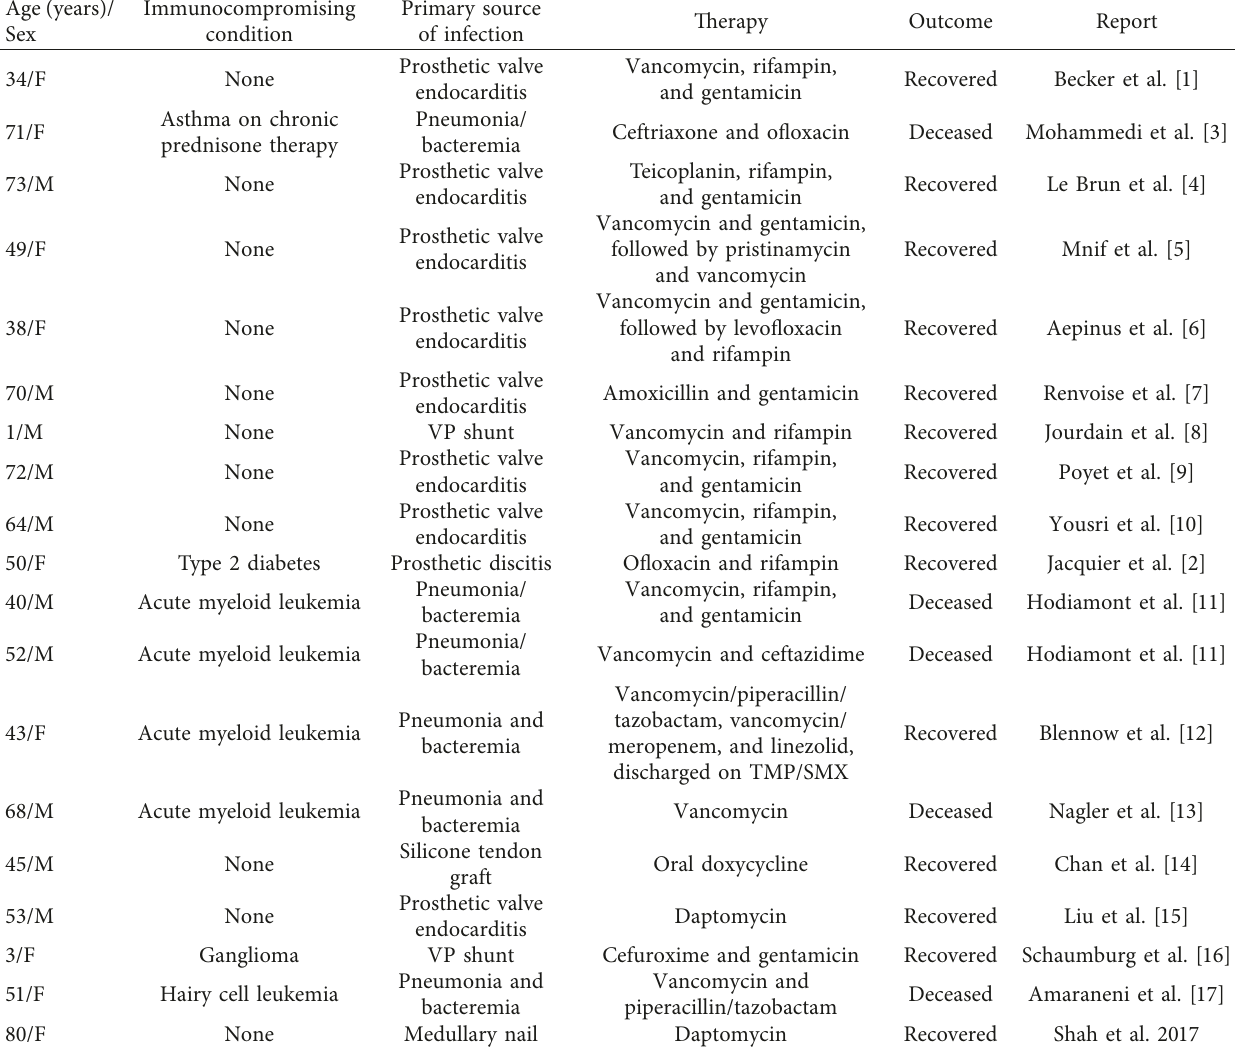
Table 1: Reported cases of Kytococcus